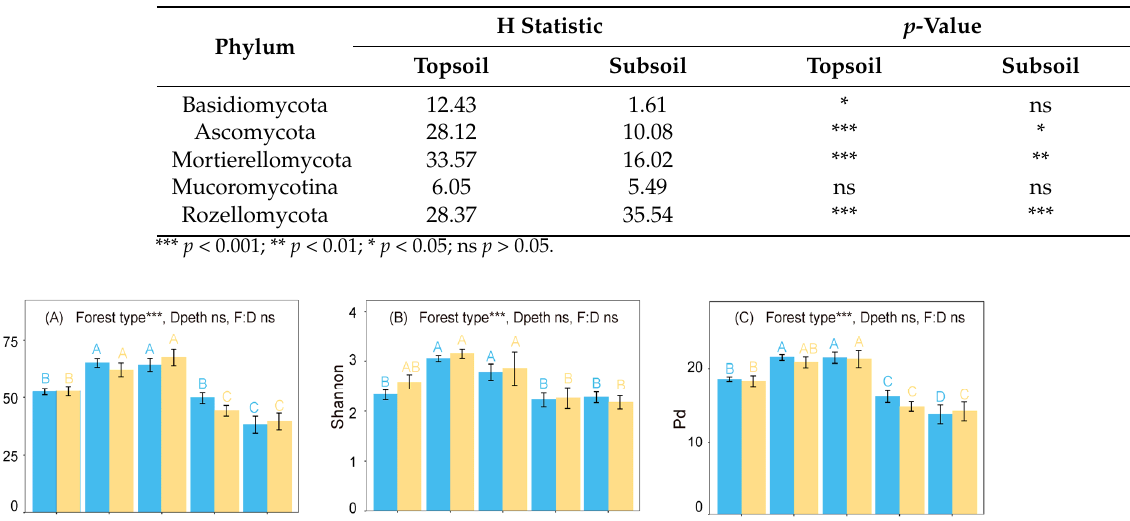
Figure 3. Multiple comparisons showing different alpha diversity of soil fungi in different forest types. ( A ) Chao 1; ( B ) Shannon; ( C ) Phylogenetic diversity. Significant differences ( p < 0.05) in different forest types are indicated by letters in different colours. Broadleaf-oriented transformation, BM; P. massoniana mature plantation, PM; P. massoniana overmature plantation, PO; P. massoniana + local broadleaved trees, PB; secondary forests, SF. *** p < 0.001; ns p >